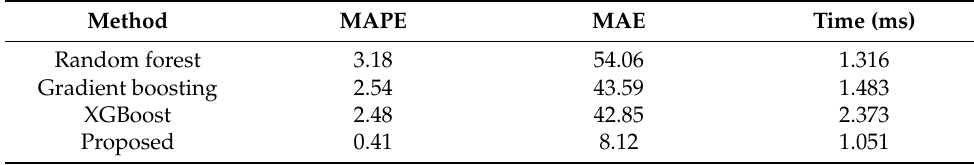
Table 19. Comparison with ML-based methods.